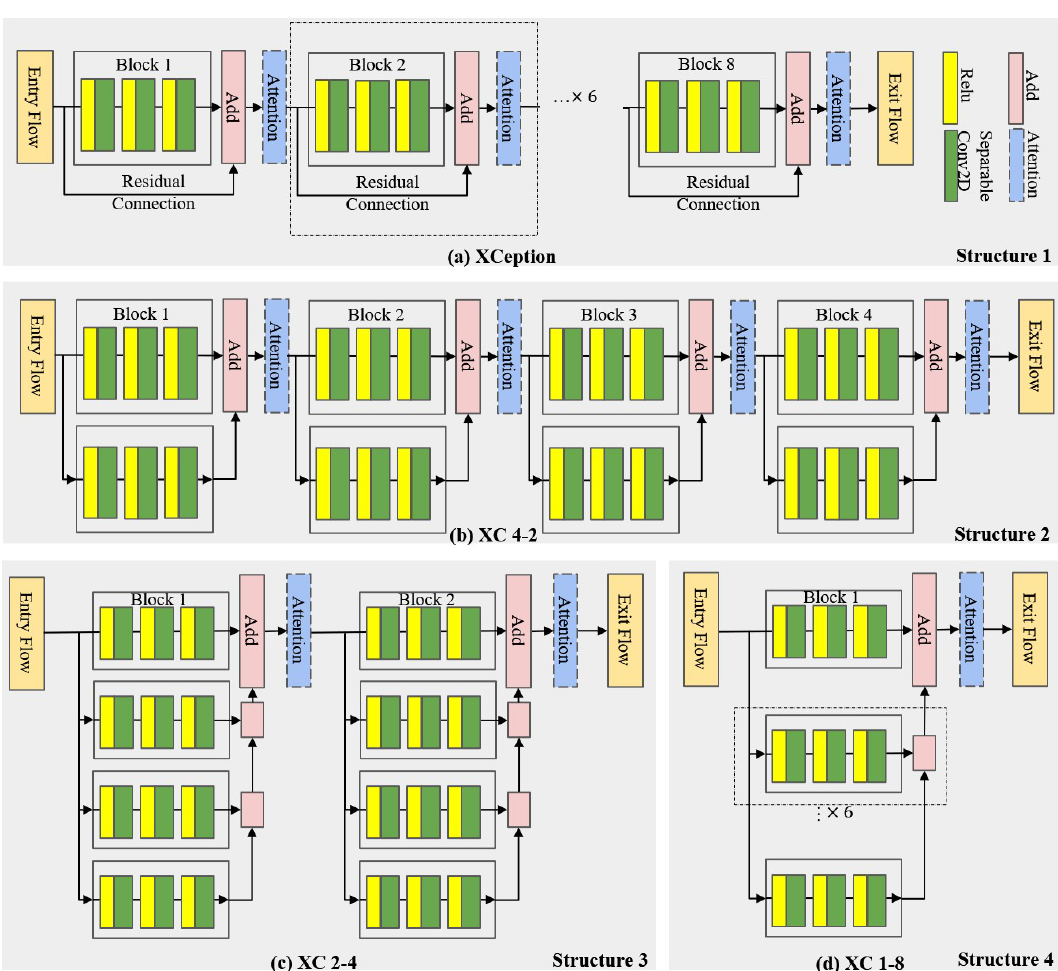
Figure 4. Attention-based branch expansion networks. The attention module is plugged at the end of each multi-branch block. ( a ) Attention-based Xception. ( b – d ) “ACE Depth-Width” networks with the same structure of the 3 new “XC”